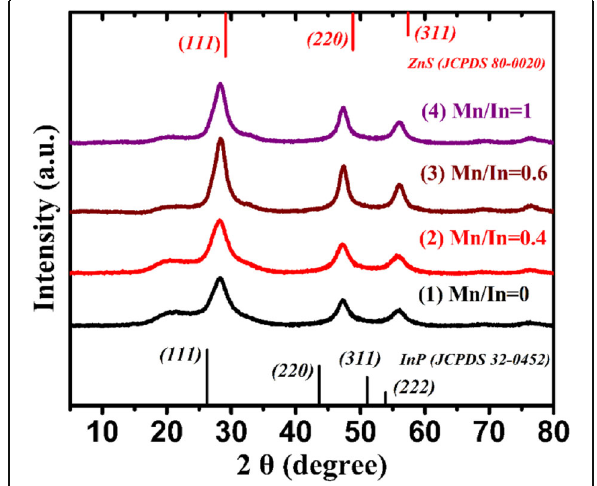
Fig. 2 The XRD patterns of Mn:InP/ZnS QDs with different Mn/In